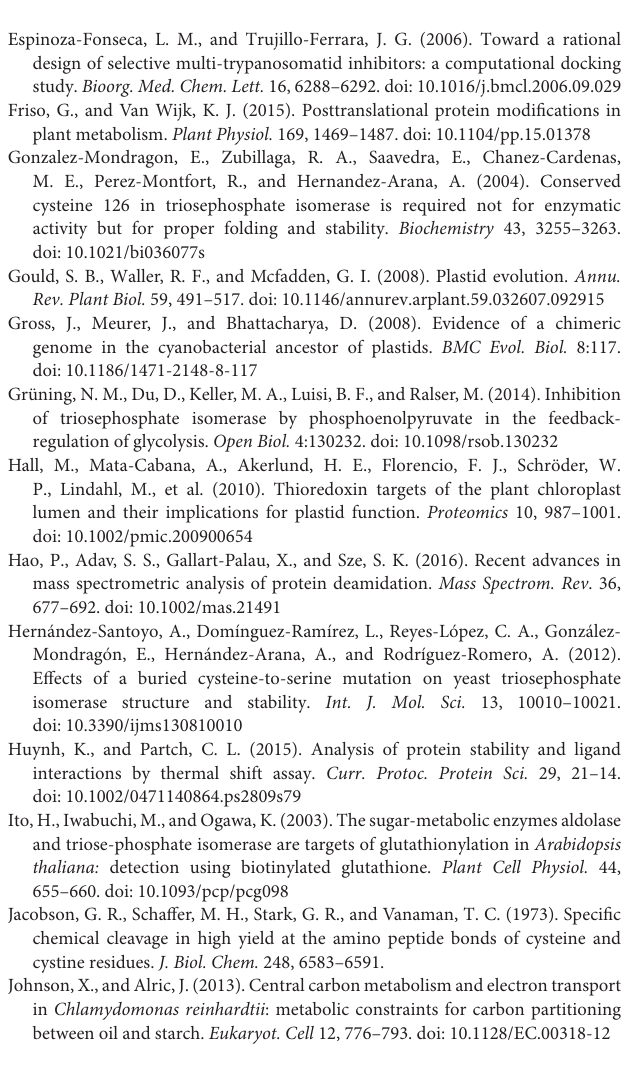
Figure S2 | Time course reaction showing the effect of GSSG, MMTS, and DTNB treatment in the enzymatic activity of wild-type SyTPI, AtcTPI, and AtpdTPI. Table S1 | Q5 Site-directed mutagenesis oligonucleotides. Table S2 | Data collection and refinement statistics of Triosephosphate isomerase from Synechocystis in complex with 2-Phosphoglycolic acid. Table S3 | Access code for the amino acid sequences used to build the Multiple amino acid sequence alignment. Table S4 | Access code for the TPI sequences used to build the phylogenetic